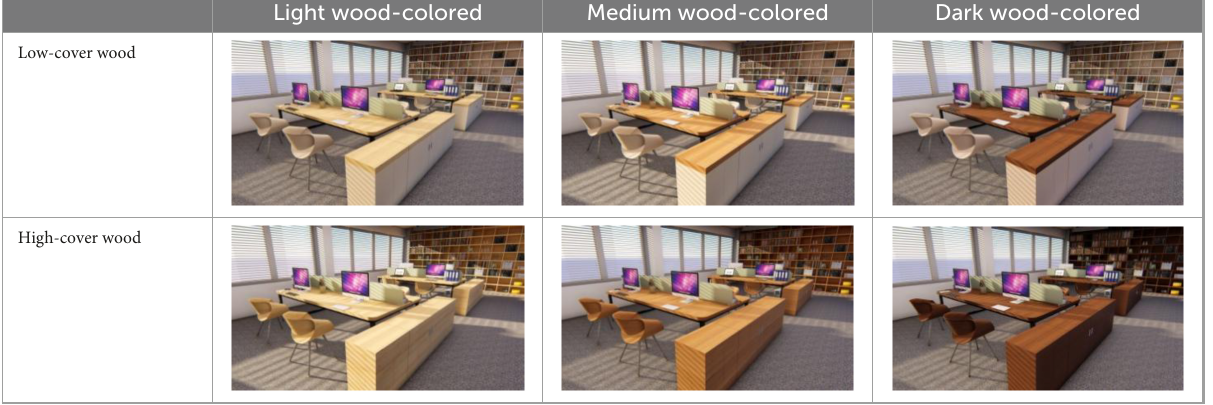
TABLE 2 The six different experimental condition. Light wood-colored Medium wood-colored Dark